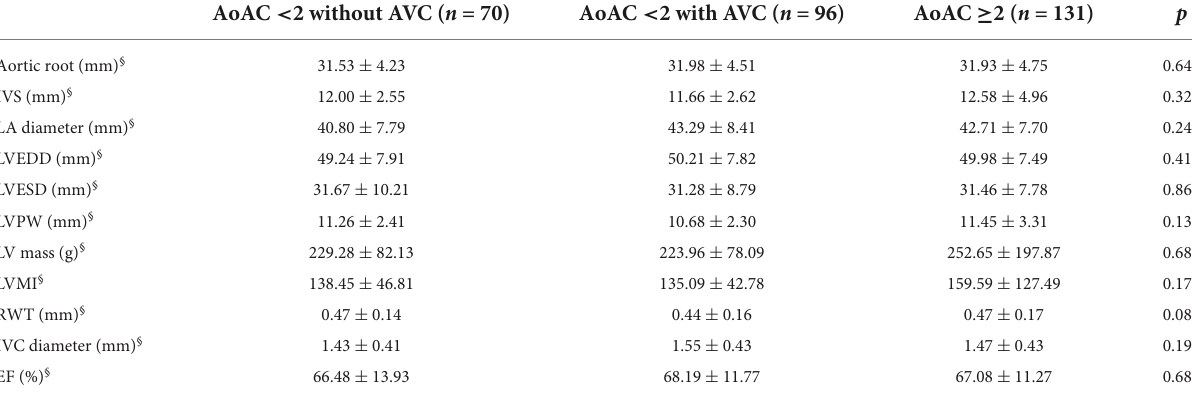
TABLE 2 Echocardiographic findings of MHD patients according to AoAC severity with and without AV